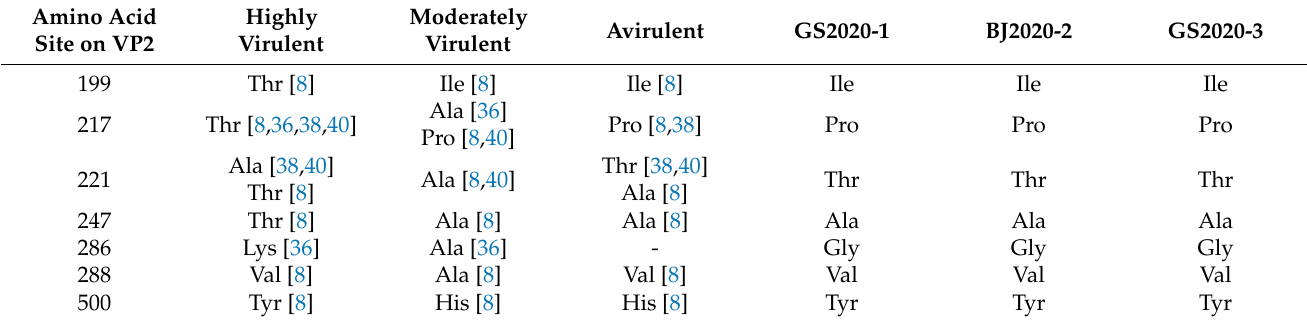
Table 5. Virulent signature analysis of Chinese genogroup V IPNV strains.